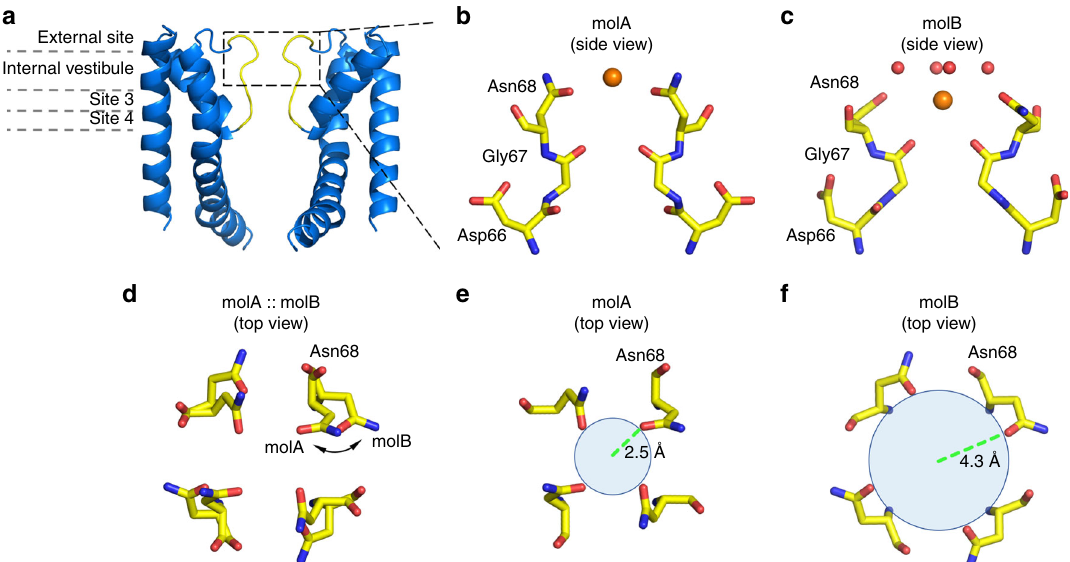
Fig. 3 Insertion of partially hydrated Na + into the dilated external site of NaK. a Side view of the overall structure (blue) of NaK in a cartoon representation, while the front and back subunits are removed for clarity. Selectivity fi lter in yellow. b , c The top half of the fi lters from molA and molB are shown in stick models, and Na + ions and waters as orange and red spheres, respectively. d The top view of the external sites from molA and molB are overlaid to illustrate the conformational change of Asn68 dilating the external site to allow Na + into the pore. e , f The top view of molA and molB, respectively, illustrating the large conformational change in Asn68 and the resulting change in diameter. As the conformation of Asn68 changes between molA and molB, the radius of the external site almost doubles. Green dashed lines indicate the radii of the circles